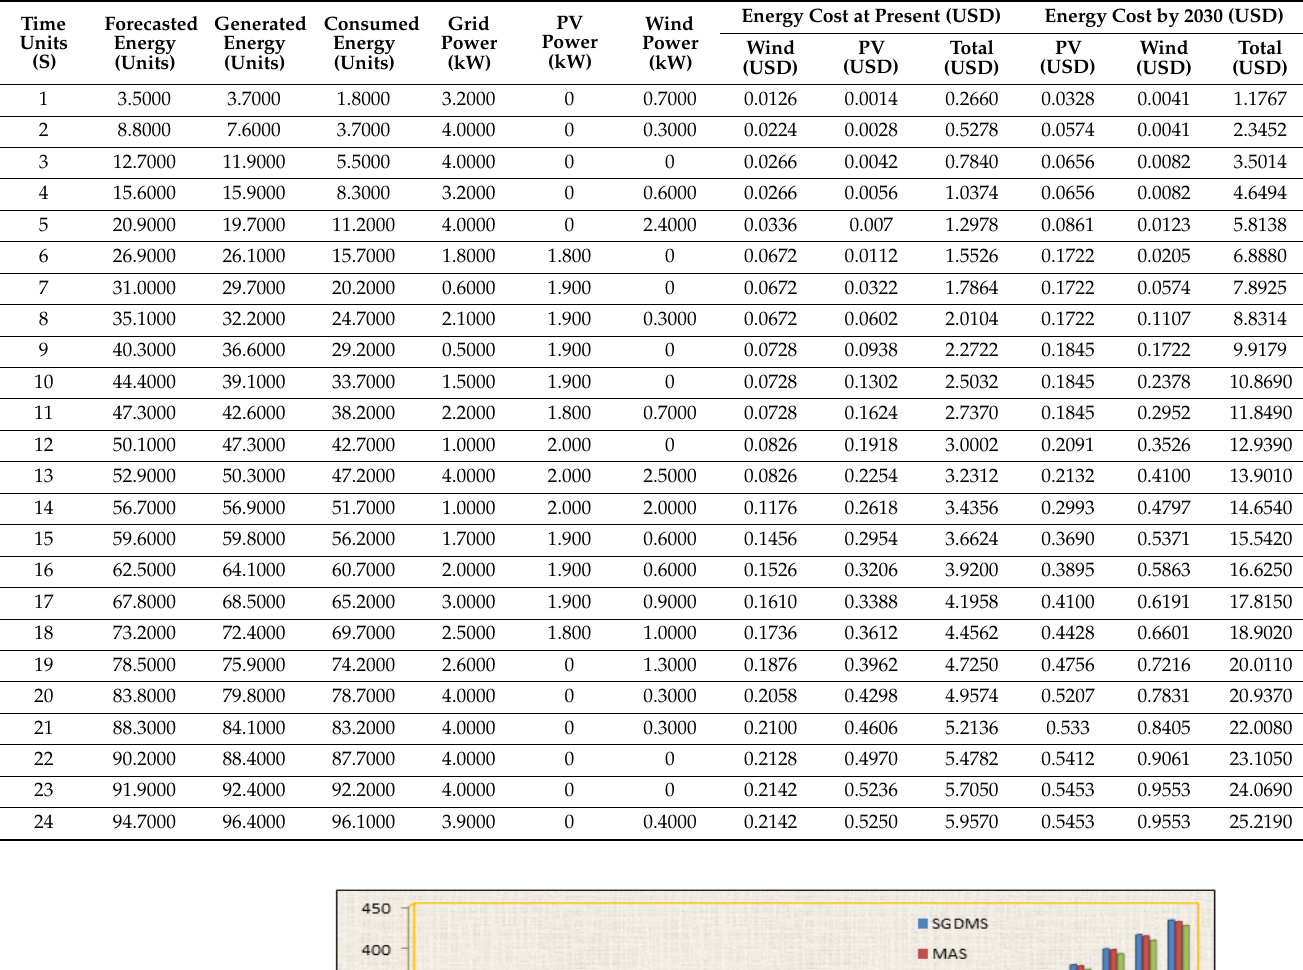
Table 8. Hybrid PV-wind energy resources with grid supply: energy, power, and energy cost details for present and future scenarios.